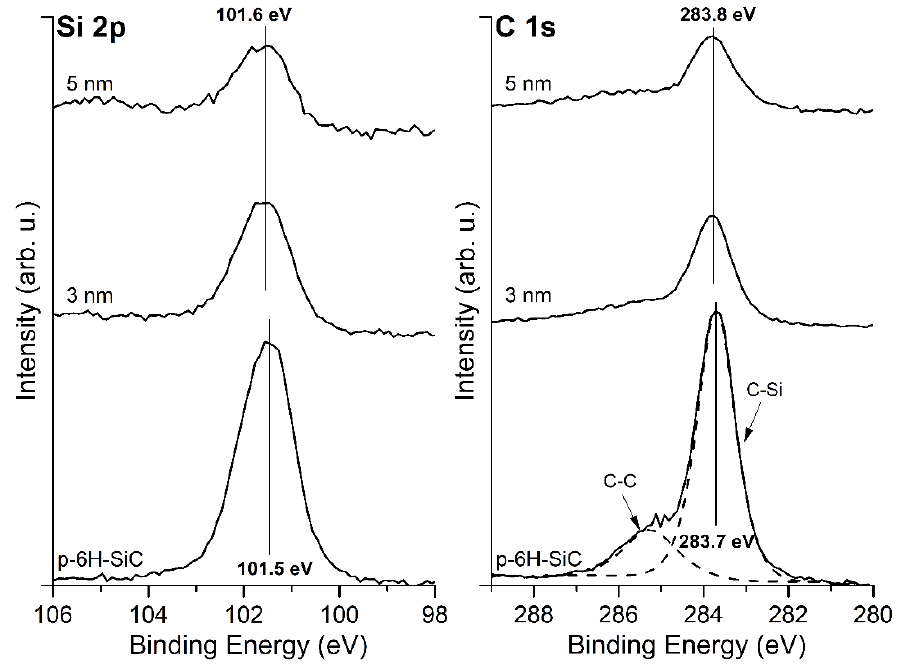
Figure 2. XPS spectra of Si 2p and C 1s core level lines for bare SiC(0001) surface and covered with MgO layers of an average thickness of 3 and 5 nm. Both peaks remain almost in the same positions after MgO deposition.